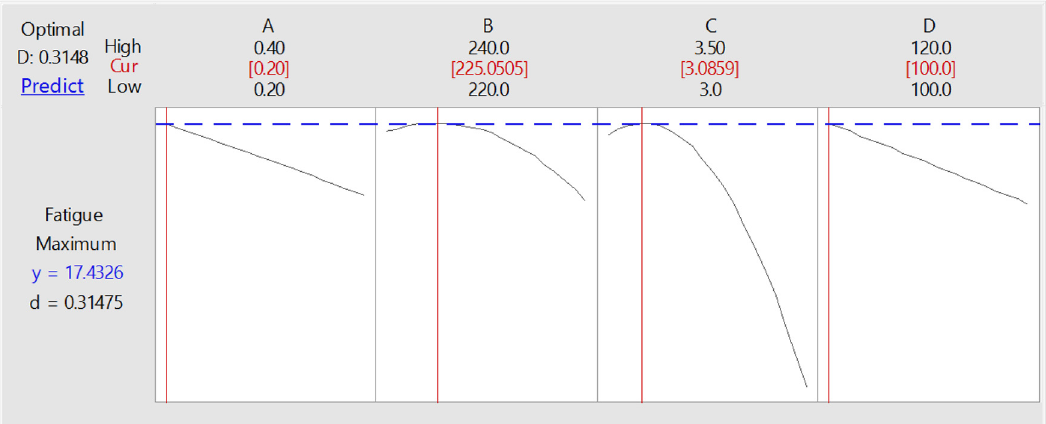
Fig. 16. SIS process variable setting curve for optimum fatigue strength